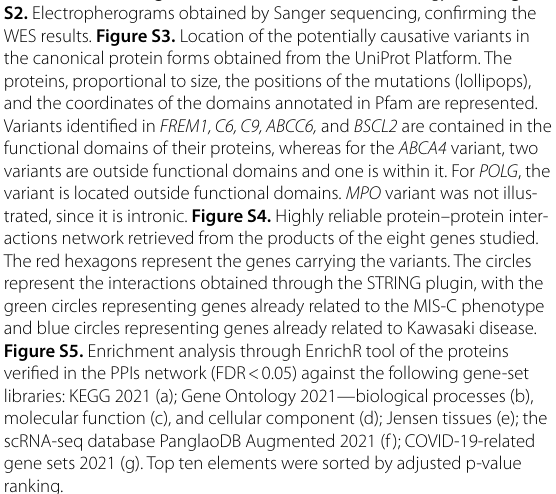
WES results. Figure S3. Location of the potentially causative variants in the canonical protein forms obtained from the UniProt Platform. The proteins, proportional to size, the positions of the mutations (lollipops), and the coordinates of the domains annotated in Pfam are represented. Variants identified in FREM1, C6, C9, ABCC6, and BSCL2 are contained in the functional domains of their proteins, whereas for the ABCA4 variant, two variants are outside functional domains and one is within it. For POLG , the variant is located outside functional domains. MPO variant was not illus‑ trated, since it is intronic. Figure S4. Highly reliable protein–protein inter‑ actions network retrieved from the products of the eight genes studied. The red hexagons represent the genes carrying the variants. The circles represent the interactions obtained through the STRING plugin, with the green circles representing genes already related to the MIS‑C phenotype and blue circles representing genes already related to Kawasaki disease. Figure S5. Enrichment analysis through EnrichR tool of the proteins verified in the PPIs network (FDR < 0.05) against the following gene‑set libraries: KEGG 2021 (a); Gene Ontology 2021—biological processes (b), molecular function (c), and cellular component (d); Jensen tissues (e); the